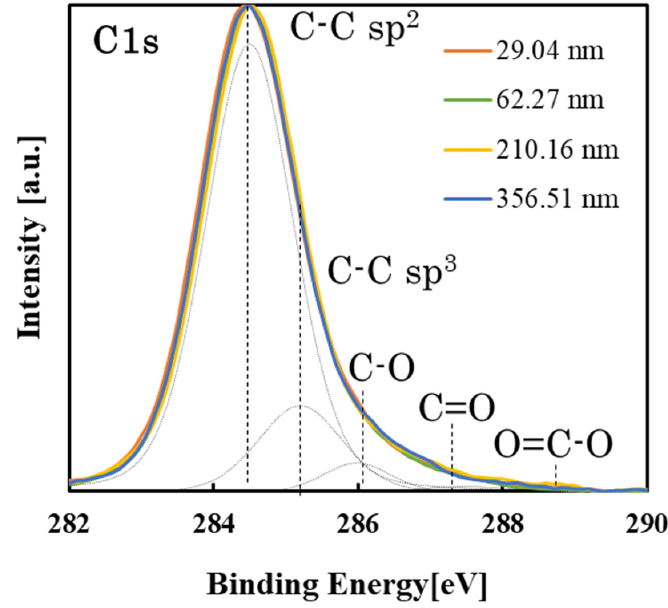
Figure 7. C1s spectra of the PLC films with different thicknesses. (The results of the no4 waveform separation spectrum are shown in the figure for reference).